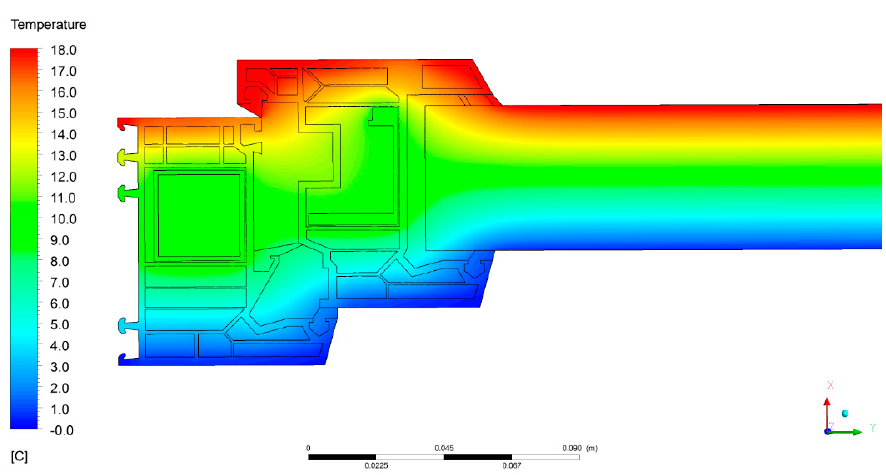
Figure 6. Temperature distribution on real PVC frame.